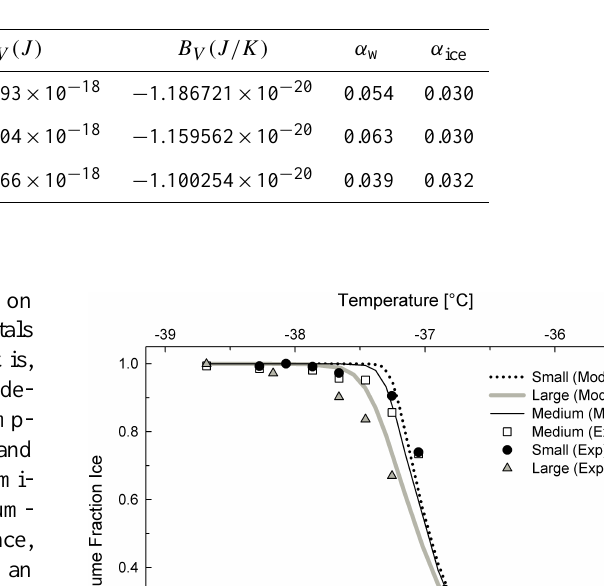
Table 1. Minimization parameters from group fits for each droplet size.